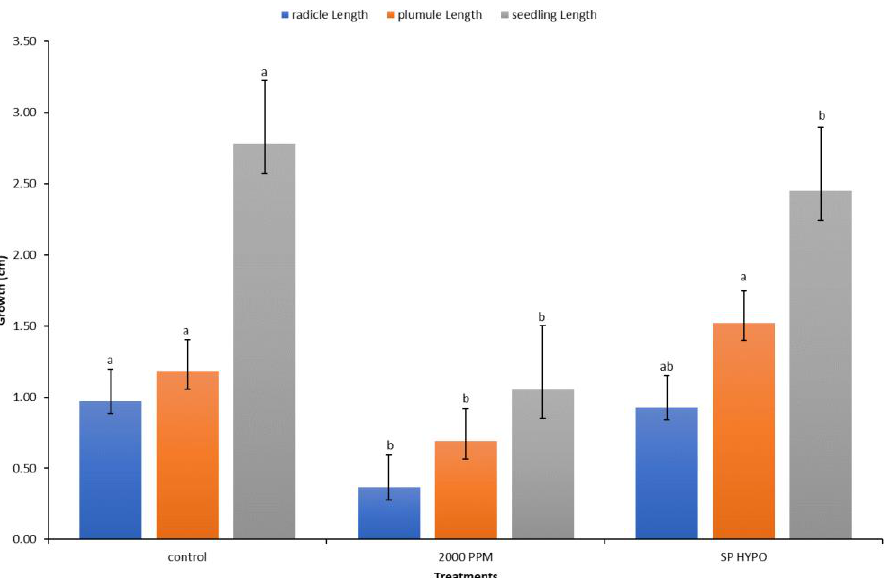
Figure 9. Response of radicles, shoots, and seedlings to two different methods of fungal (sterilization and growth media). Values denoted with different letters are significantly different at p < 0.05.